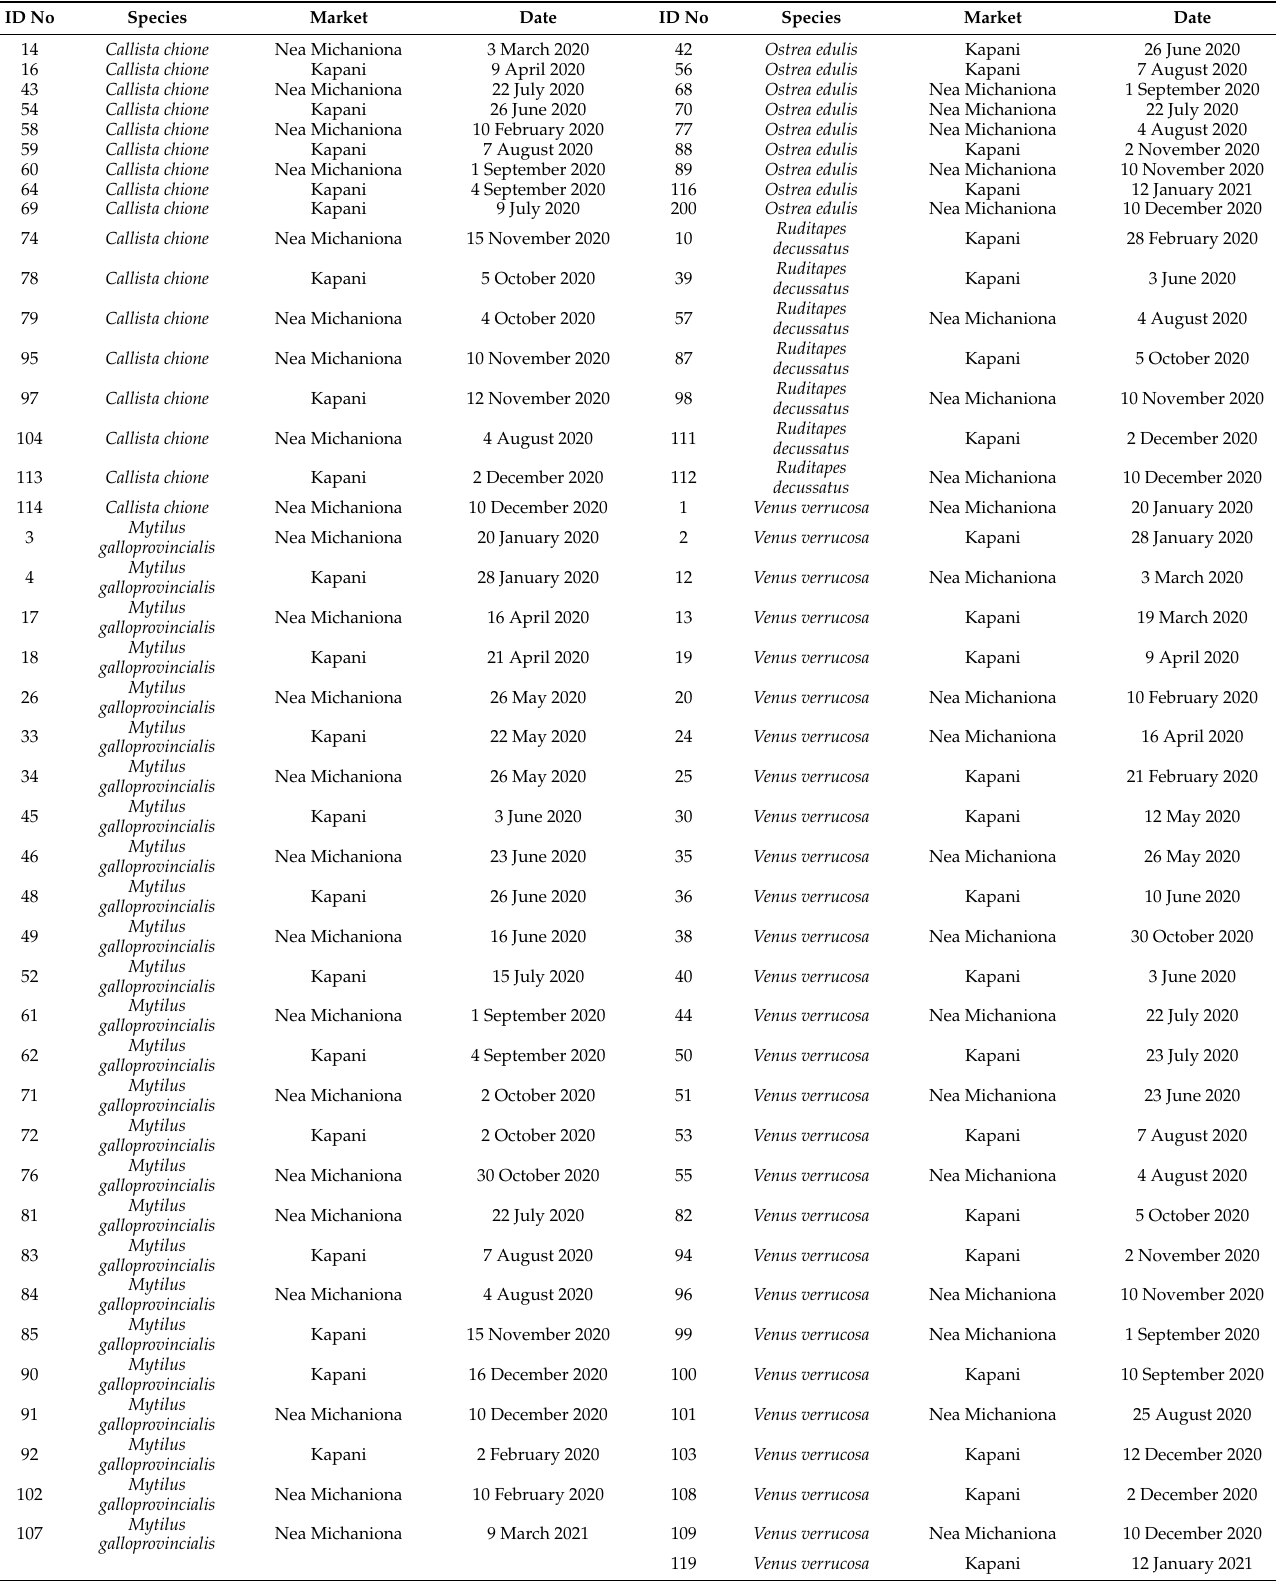
Table 1. Id, species, market, and date of each sample